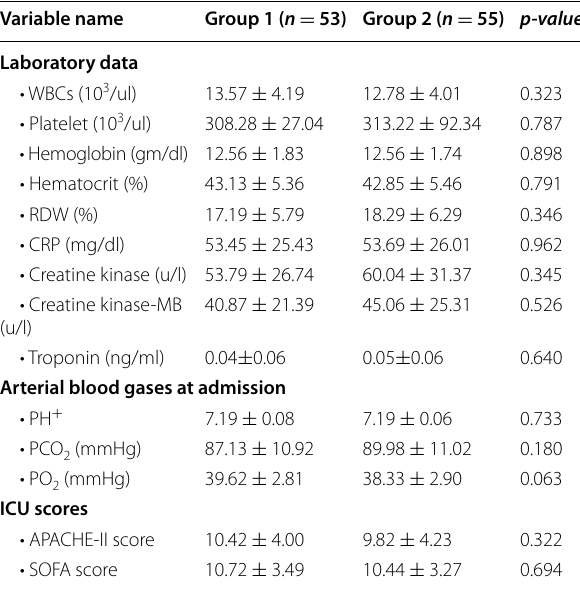
Table 2 Baseline laboratory data, arterial blood gases, and ICU scores among enrolled patients ( n =